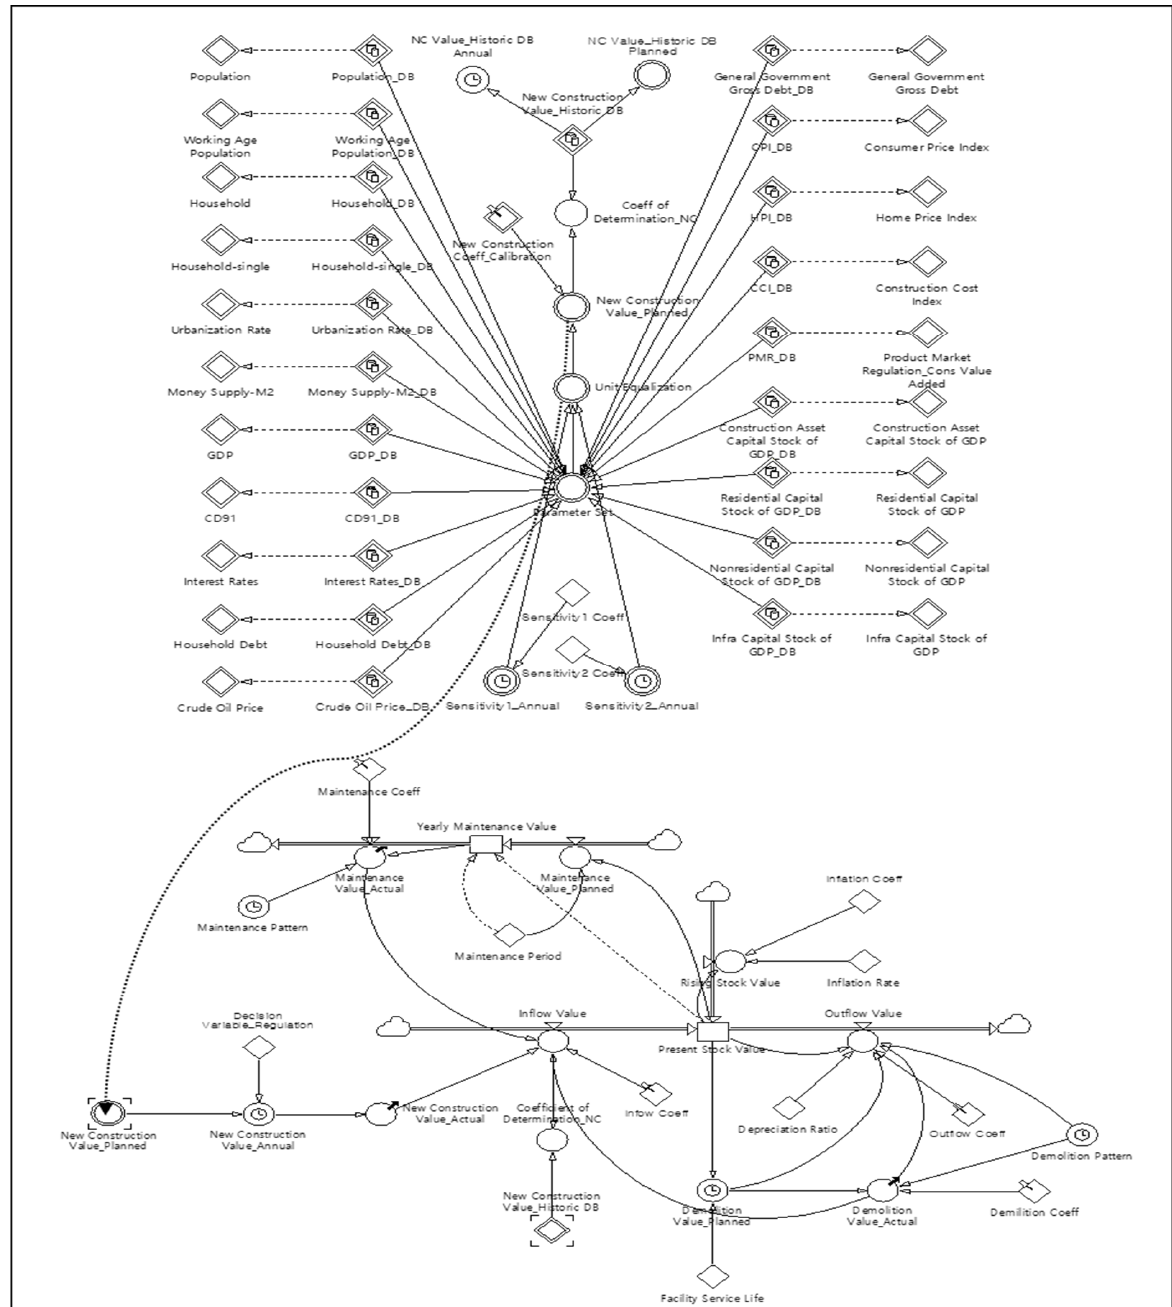
Figure 6. Structure of the construction market forecasting module.